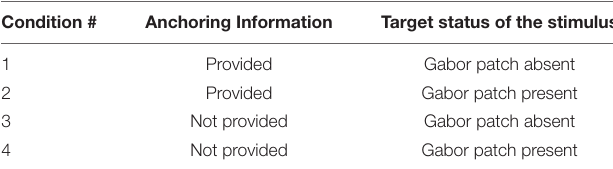
TABLE 5 | Experimental conditions in Experiment